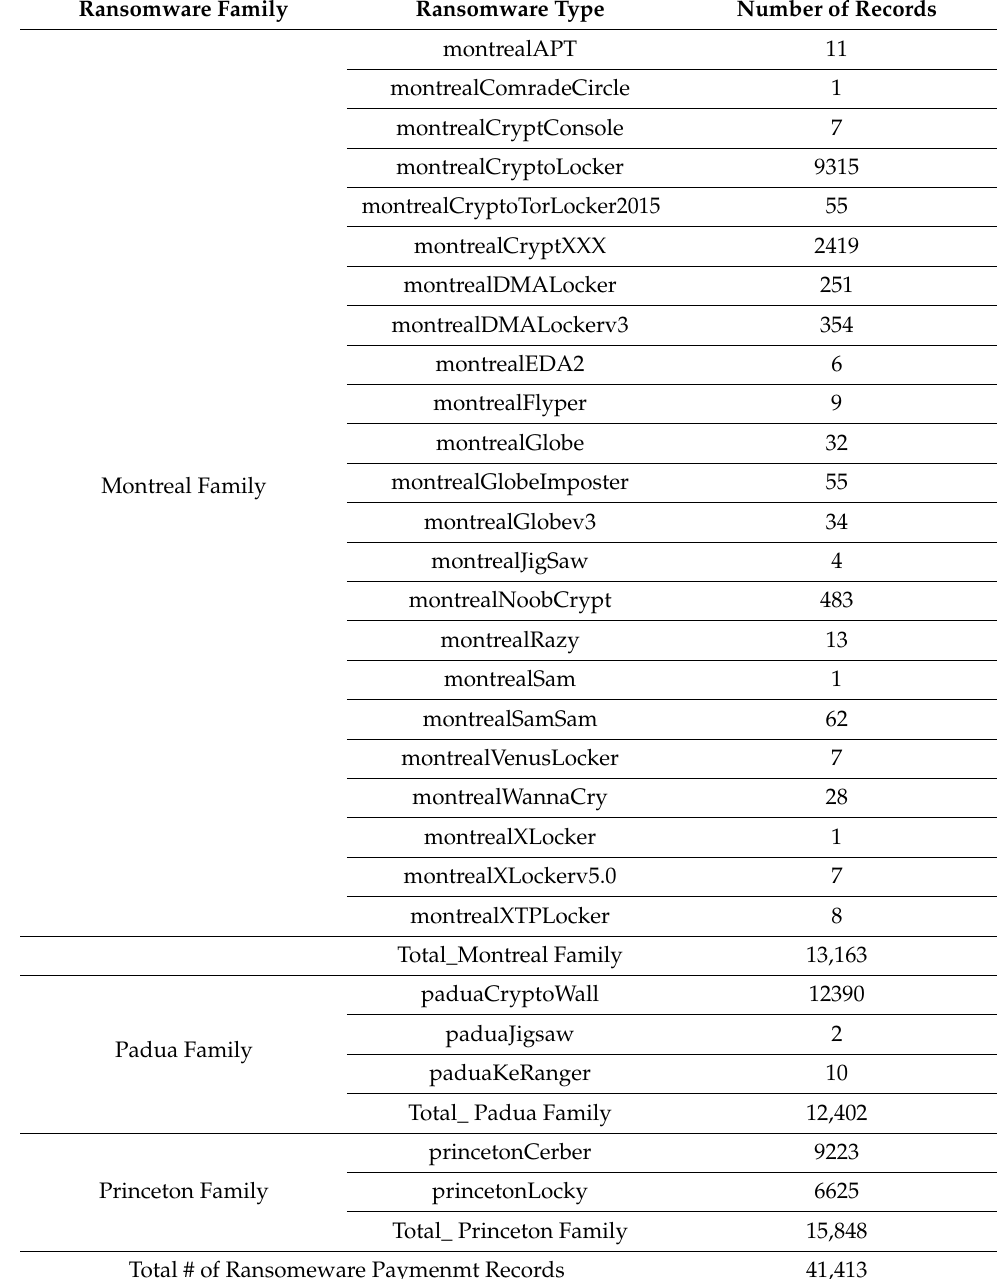
Table 1. Bitcoin Transactions Dataset